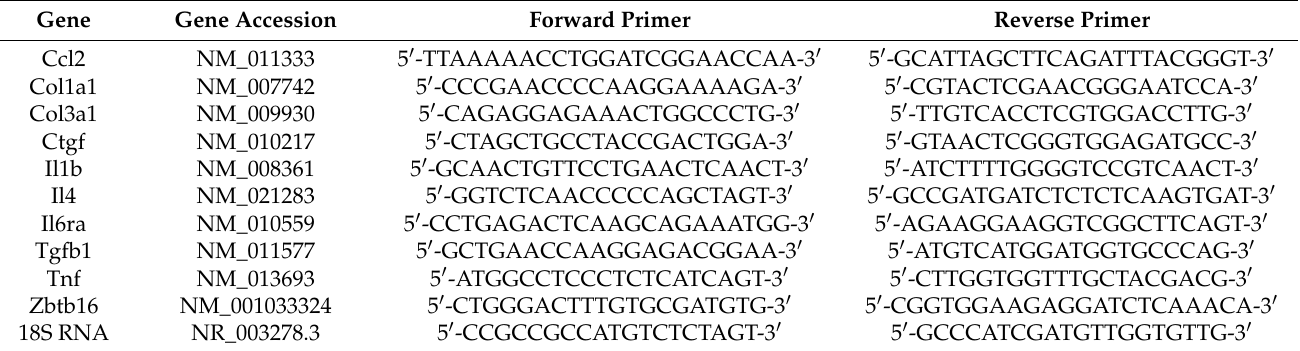
Table 1. Primer sequences used for quantitative